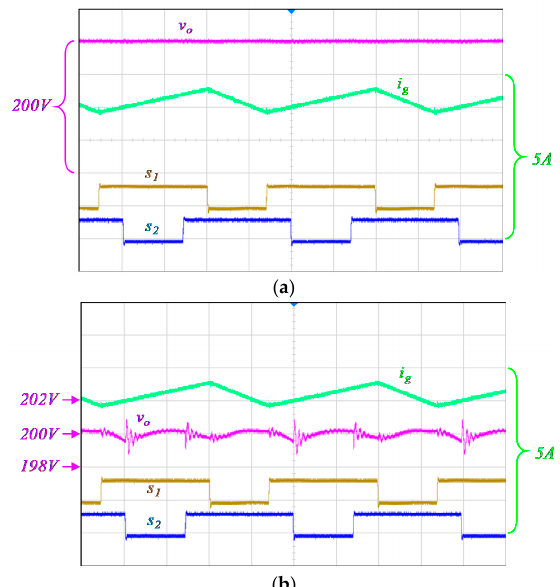
Figure 14. ( a ) The output voltage, input current, and firing signals when D = 0.6476 ( Vg ≈ 25 V) in the proposed strategy and ( b ) same signals with a zoom in the output voltage ripple.